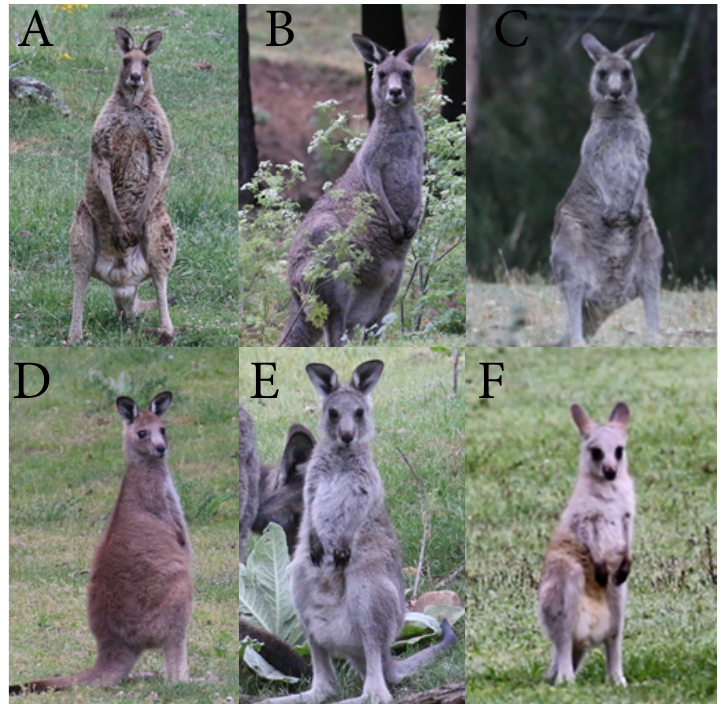
Figure 2. Demography classification reference images of ( A ) large adult, ( B ) medium adult, ( C ) small adult, ( D ) sub-adult, ( E ) young-at-foot, and ( F ) pouch